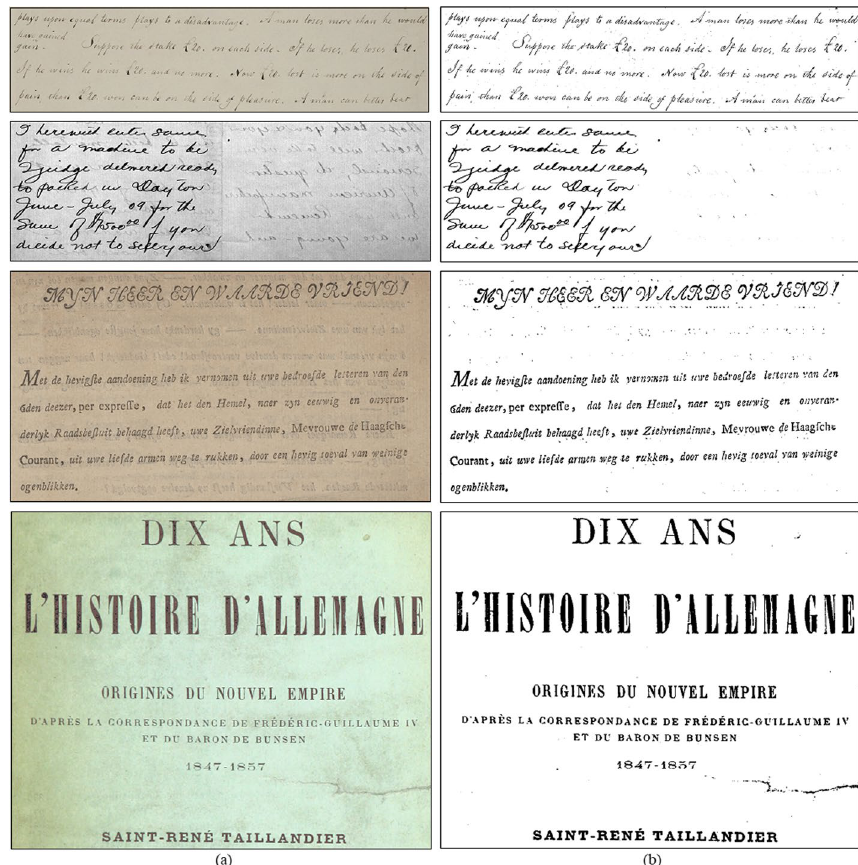
Fig. 5 Images binarization results from DIBCO 2013: a Original degraded images, b recovered text by the proposed non-local